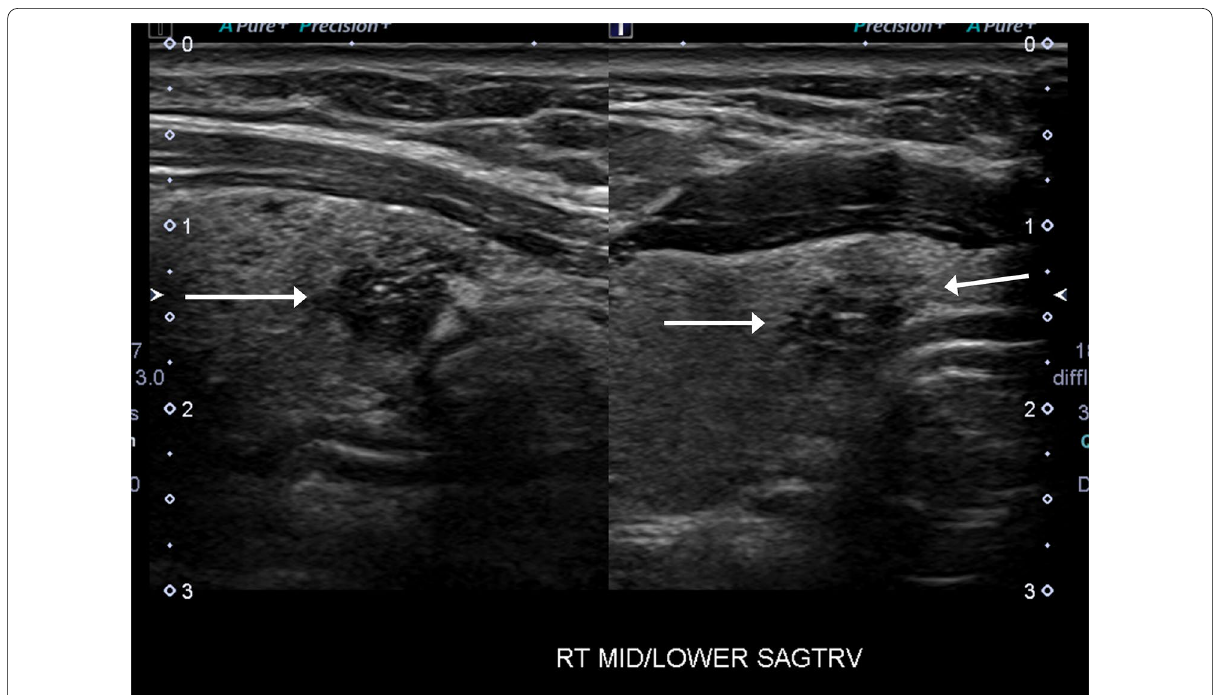
Fig. 10 44-Year-old female with right lobe PTC. Sagittal and transverse images show that the hypoechoic PTC (arrows) has an acute angle of contact with the trachea. The patient was offered AS and continues to be monitored as per study protocol